Question: In a single sentence, describe what this figure presents.
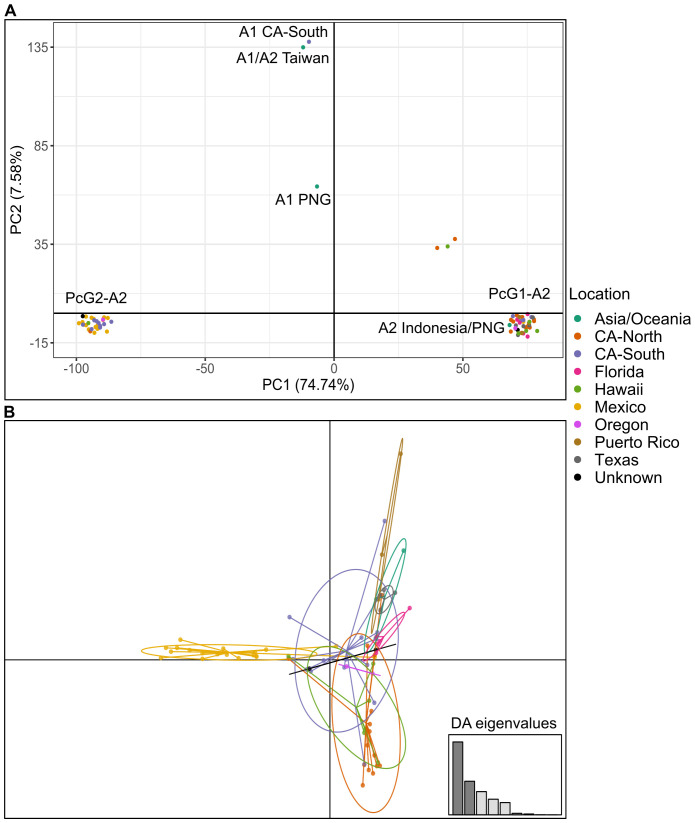
Answer: Multivariate analyses of the P. cinnamomi populations from the U.S.A. and Mexico after clone correction. (A) Principal component analysis (PCA) plot showing two principal components, in which PC1 reflects 74.74%, and PC2 reflects 7.58% of the total variation. Phytophthora cinnamomi reference isolates corresponding to the two A2 panglobal clonal lineages (PcG1-A2 and PcG2-A2), several A1 and A2 isolates from Taiwan, Papua New Guinea (PNG), and Indonesia, as well as an A1 isolate from CA-South collected from Camelia are indicated. (B) Discriminant analysis of principal components (DAPC) plot indicating the different PC groups, where the points represent the individuals and the ellipses represent the geographical locations. DA eigenvalues distribution is also displayed. Points in each plot reflect the individual by geographical location: Asia/Oceania = teal, CA-North = orange, CA-South = blue, Florida = pink, Hawaii = green, Mexico = yellow, Oregon = purple, Puerto Rico = brown, Texas = gray, and Unknown region from California = black.